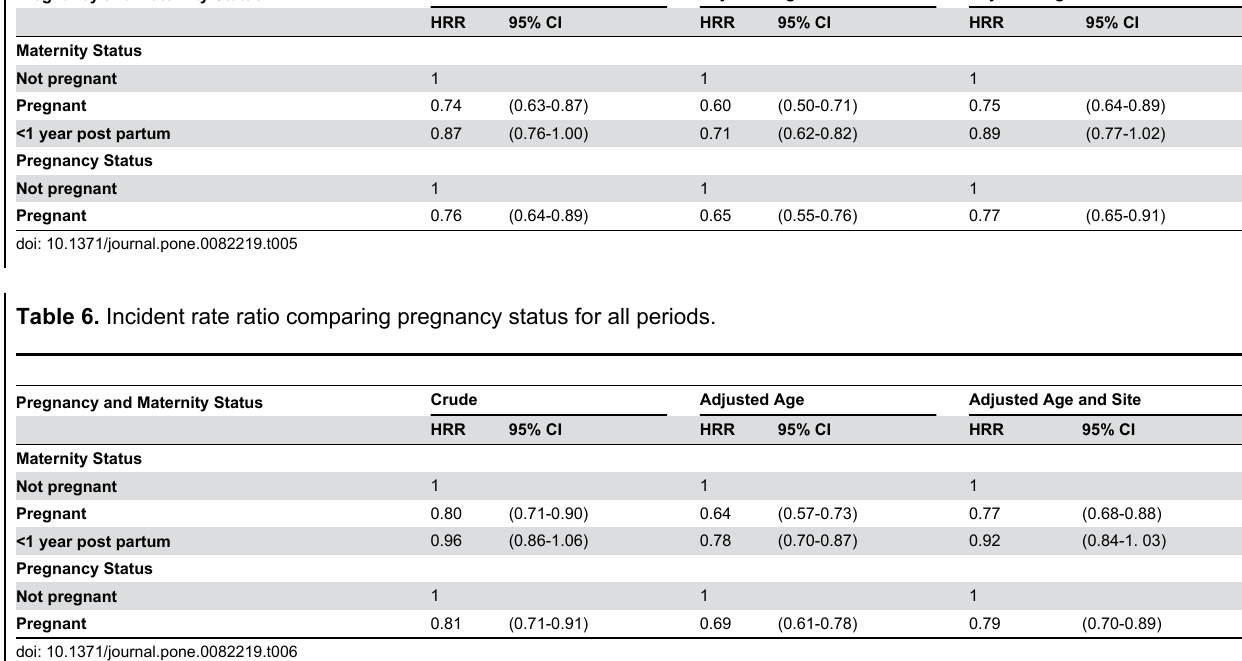
Table 5. Incident rate ratio comparing pregnancy status for the period post widespread PMTCT.